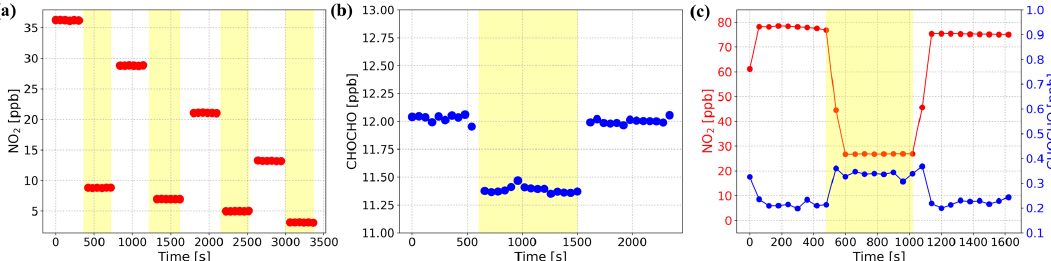
Figure 8. (a) NO 2 only test: a concentration gradient of NO 2 gas samples was measured twice, with the NPC on (yellow overlay) and off. The removal efficiency is constant at 76% for different NO 2 concentrations. (b) GLY only test: the constant concentration of GLY produced by the standard gas generator was measured, with the NPC on (yellow overlay) and off. A small fraction of the GLY (5%) was photolyzed by the NPC. (c) NO 2 and GLY mixture test: well-mixed NO 2 and GLY was measured, with the NPC on (yellow overlay) and off. The concentration of NO 2 dropped while the NPC was running and that of GLY increased. After the NPC was turned off, their concentrations returned to the same level as before the NPC was turned